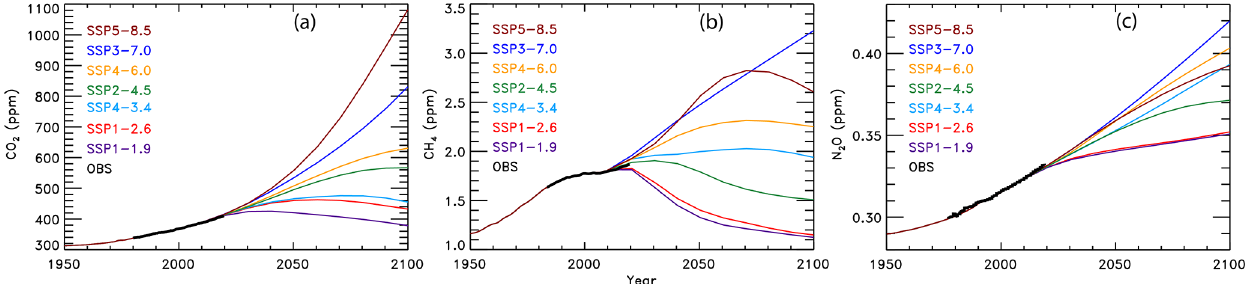
Figure 2. Observed and projected greenhouse gas mixing ratios. (a) Carbon dioxide abundances from observations (black) and seven of the ScenarioMIP SSPs (colors, as indicated). (b) Methane abundances from observations and ScenarioMIP SSPs. (c) Nitrous oxide abundances from observations and ScenarioMIP